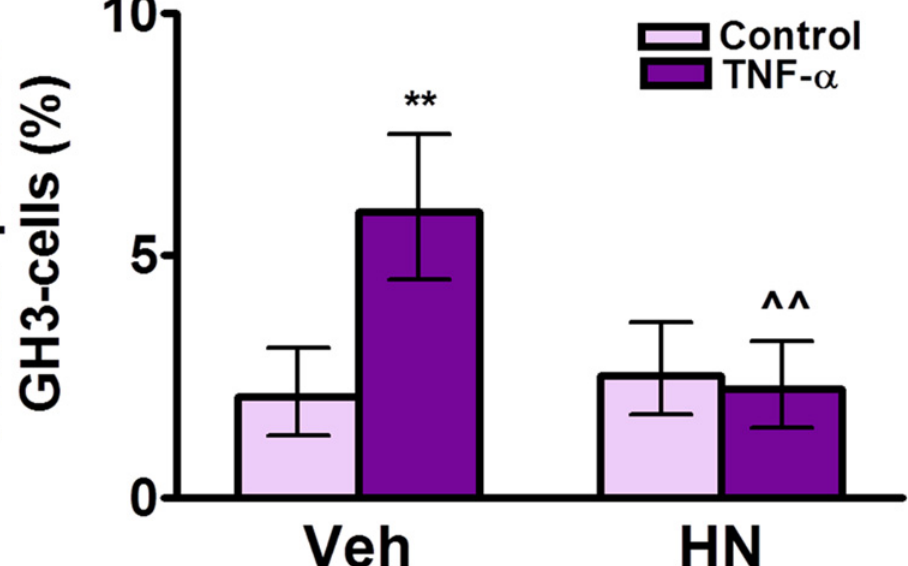
Fig 8. HN protects GH3 cells from TNF- α -induced apoptosis. Cultured GH3 cells were incubated with HN (0.5 μ M) for 2 h before adding TNF- α (50 ng/ml) for 24 h. Apoptosis was assessed by the TUNEL method. Each column represents the percentage ± CL of TUNEL-positive cells (n (cid:1) 1000 cells/group). Data from two separate experiments were analyzed by χ 2 test. ** p < 0.01 respective control without TNF- α , ^^ p < 0.01 vs respective control without